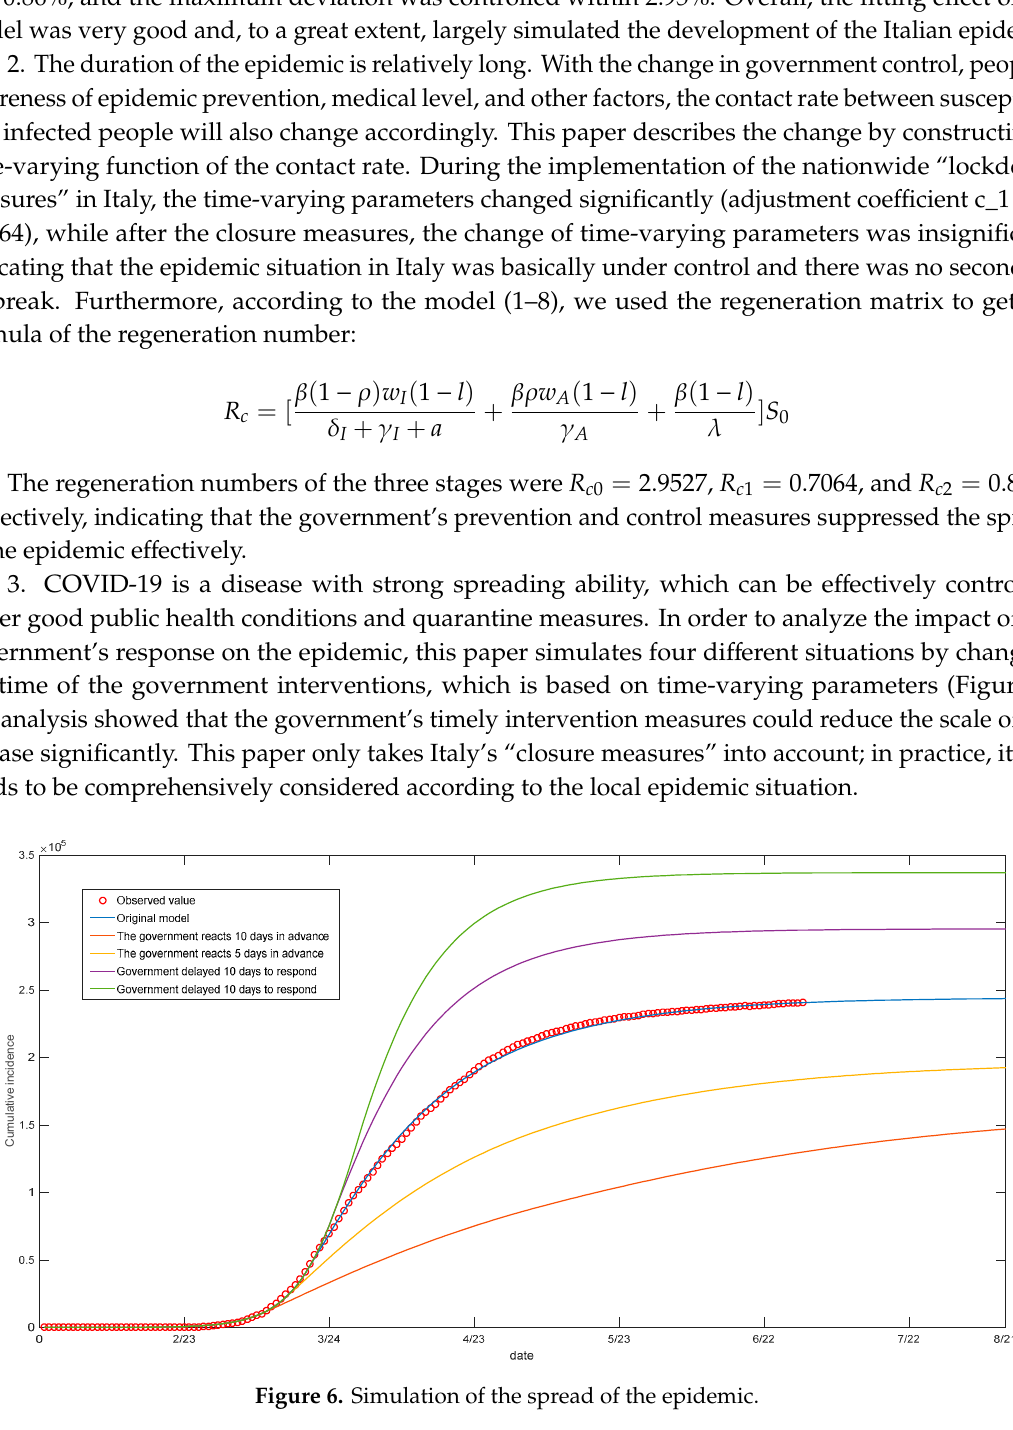
7 of 11 Table 2. Model fitting effect. Region